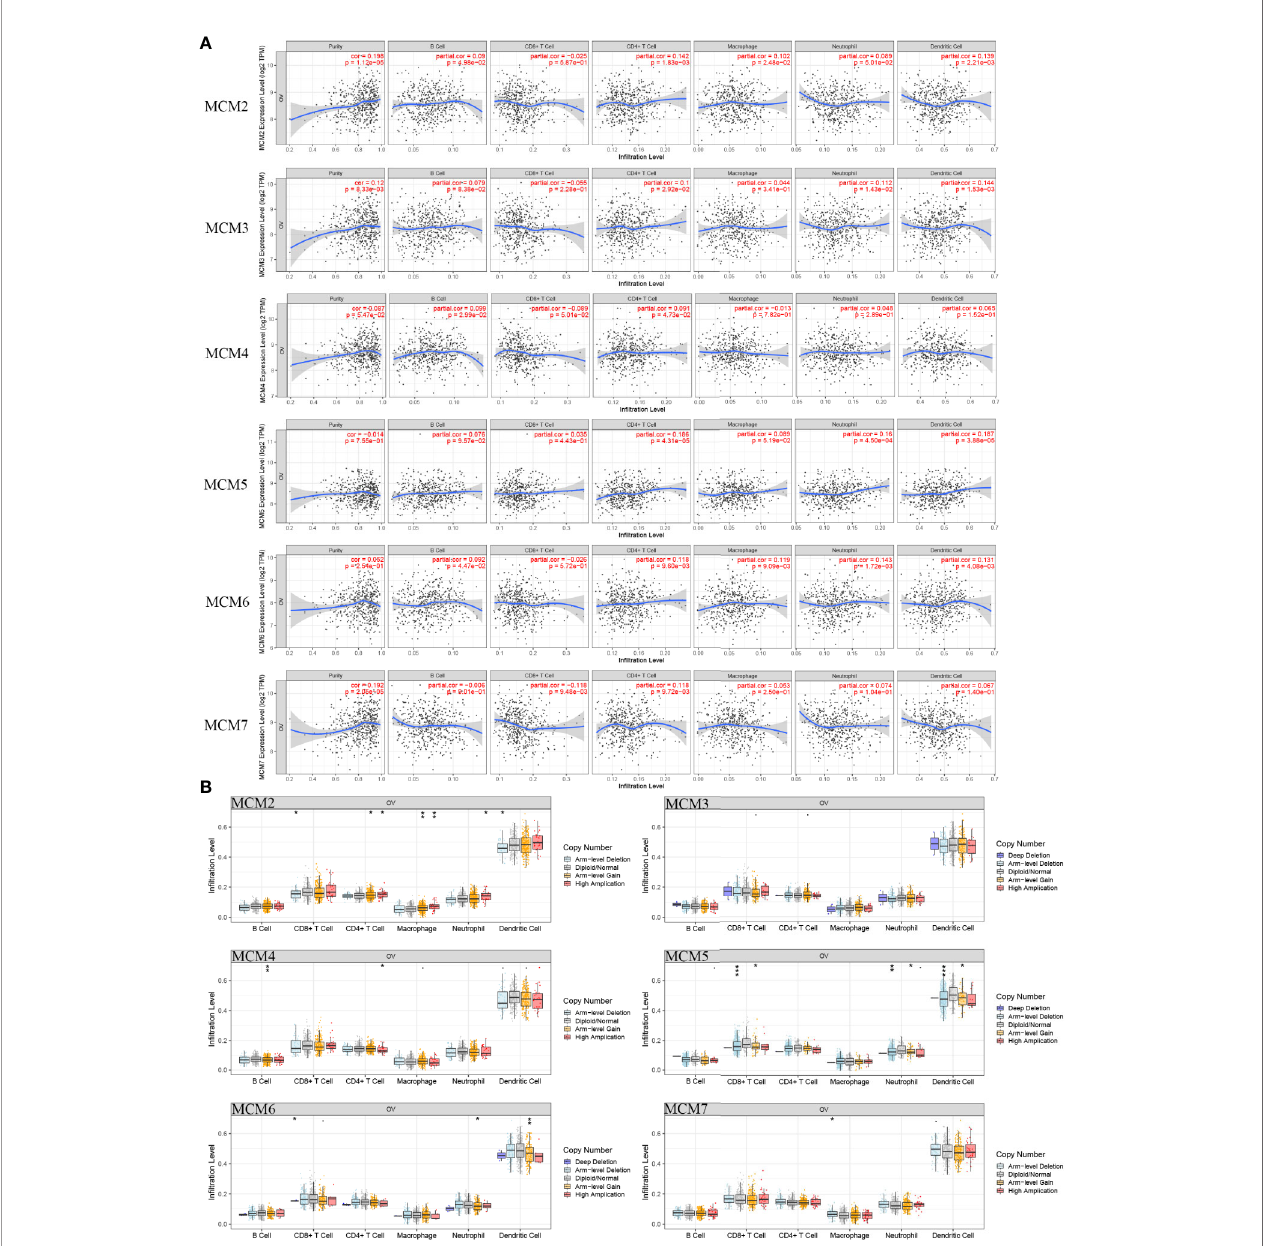
FIGURE 10 | Immune in fi ltration of the MCMs (Log Ratio > 10). (A) Cancer purity and immune in fi ltration. (B) CNV affecting the distribution based on the TIMER database. *p < 0.05, **p < 0.01, ***p <